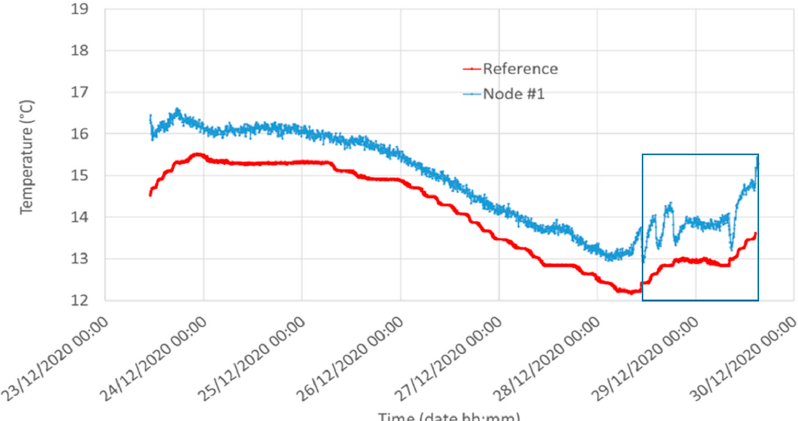
Figure 14. Temperature measured by the reference system (red, 5 cm underground) and the LM35 mounted in Node #1 (blue) in Silty Loam. The rectangular area shows the region where we realized the calibrations of Section 6.2.